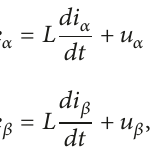
Figure 2: Stable vector diagram of WM rectifier based on virtual flux